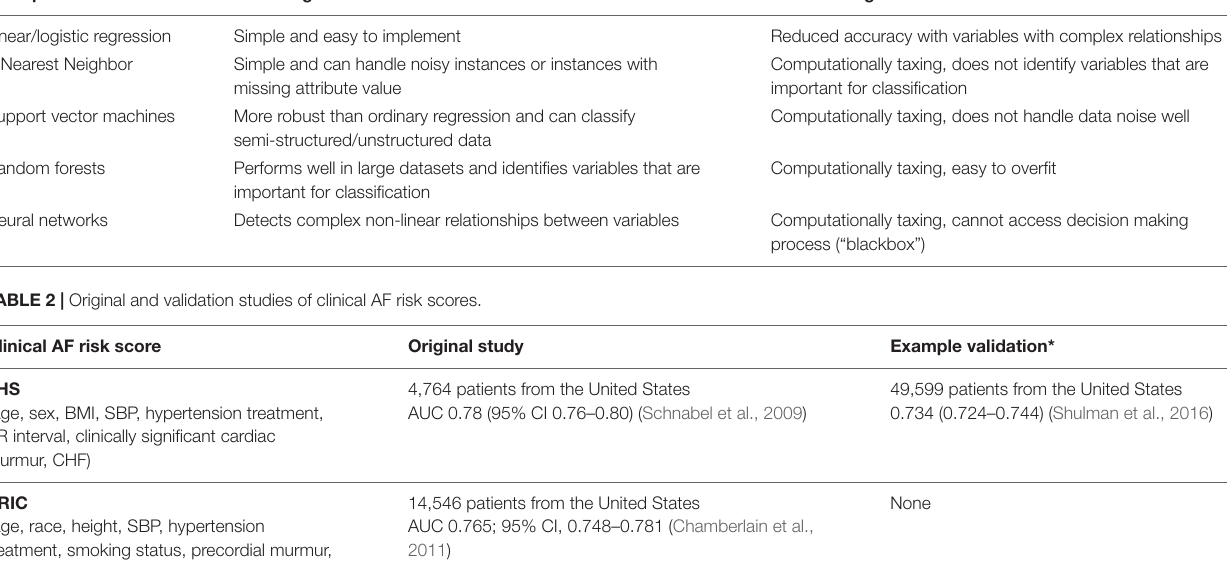
TABLE 1 | Advantages and disadvantages of different supervised machine learning techniques.